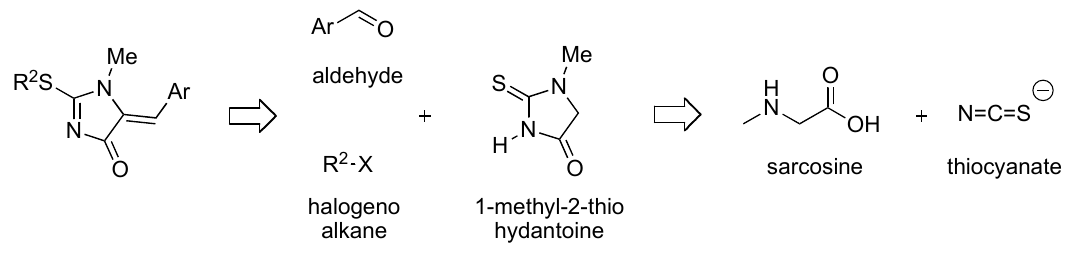
Scheme 1. Route used for the synthesis of 2-alkylthio-5-arylmethylene-1-methyl-1,5- dihydro-4 H -imidazol-4-ones. OMe N H